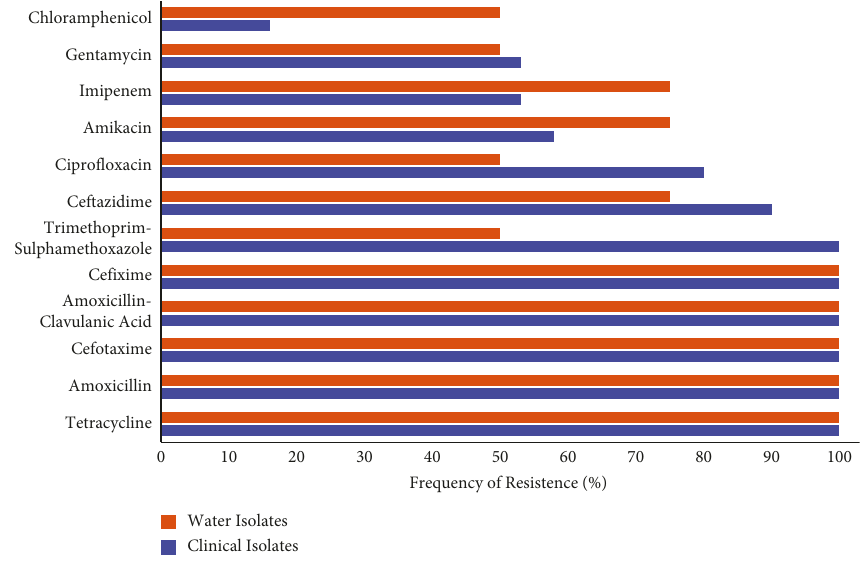
Figure 2: Drug resistance pattern in E. coli isolates from clinical and water